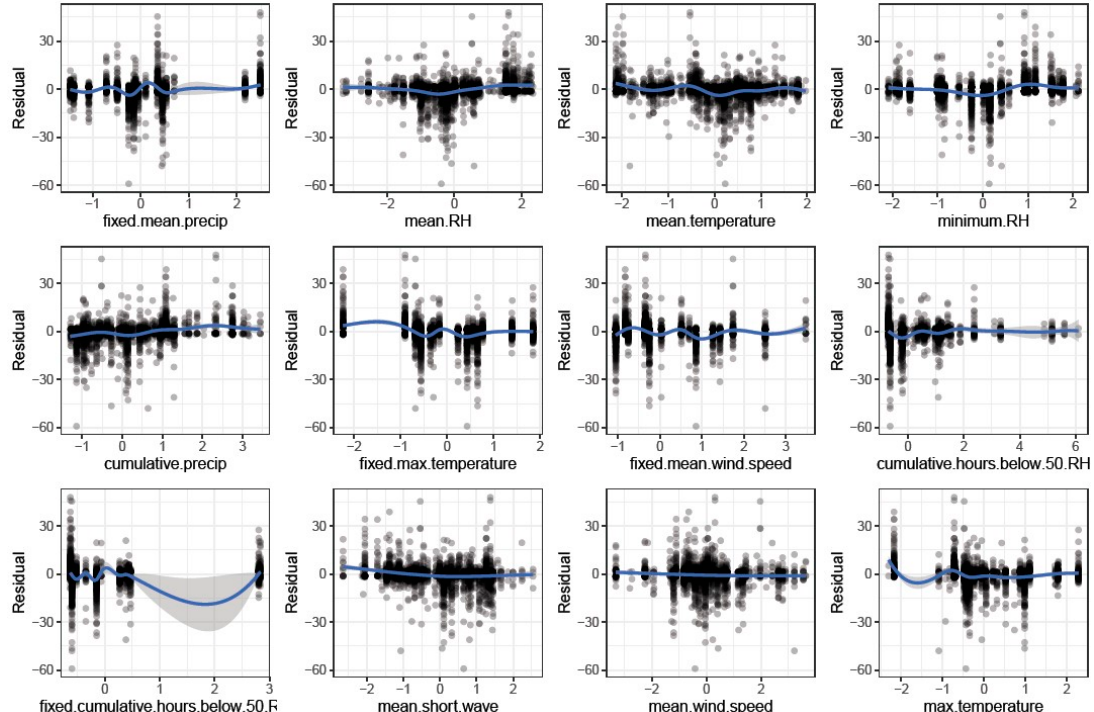
Figure 4. Relationships between weather variables and percent physical dormancy residuals of the environment, genotype by environment, and error. Negative residuals indicate observations with high physical dormancy, while positive residuals indicate observations with low physical dormancy relative to genetic and technical replicate effects. Weather variables on the x-axes were centered and scaled prior to analysis. Blue lines show nonparametric smoothing splines created using generalized additive models. Shaded blue areas around blue lines show the standard error of the spline fit.